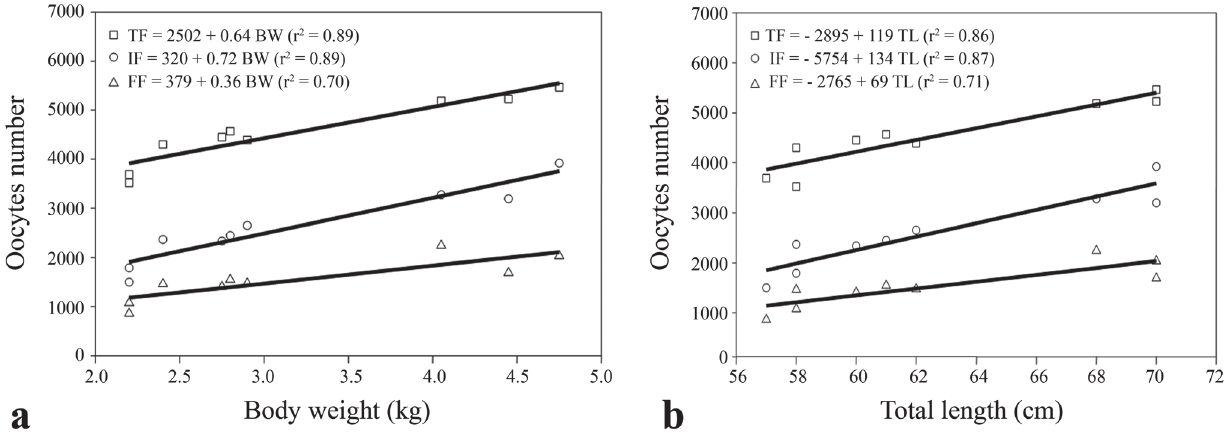
Fig. 1. Linear relationships of total fecundity (TF), initial fertility (IF) and final fertility (FF) to variations in body weight (BW) ( a ) and total length (TL) ( b ), obtained simultaneously from nine Lophiosilurus alexandri females submitted to hypophysation at Três Marias Hydrobiology and Hatchery Station in January 1997.